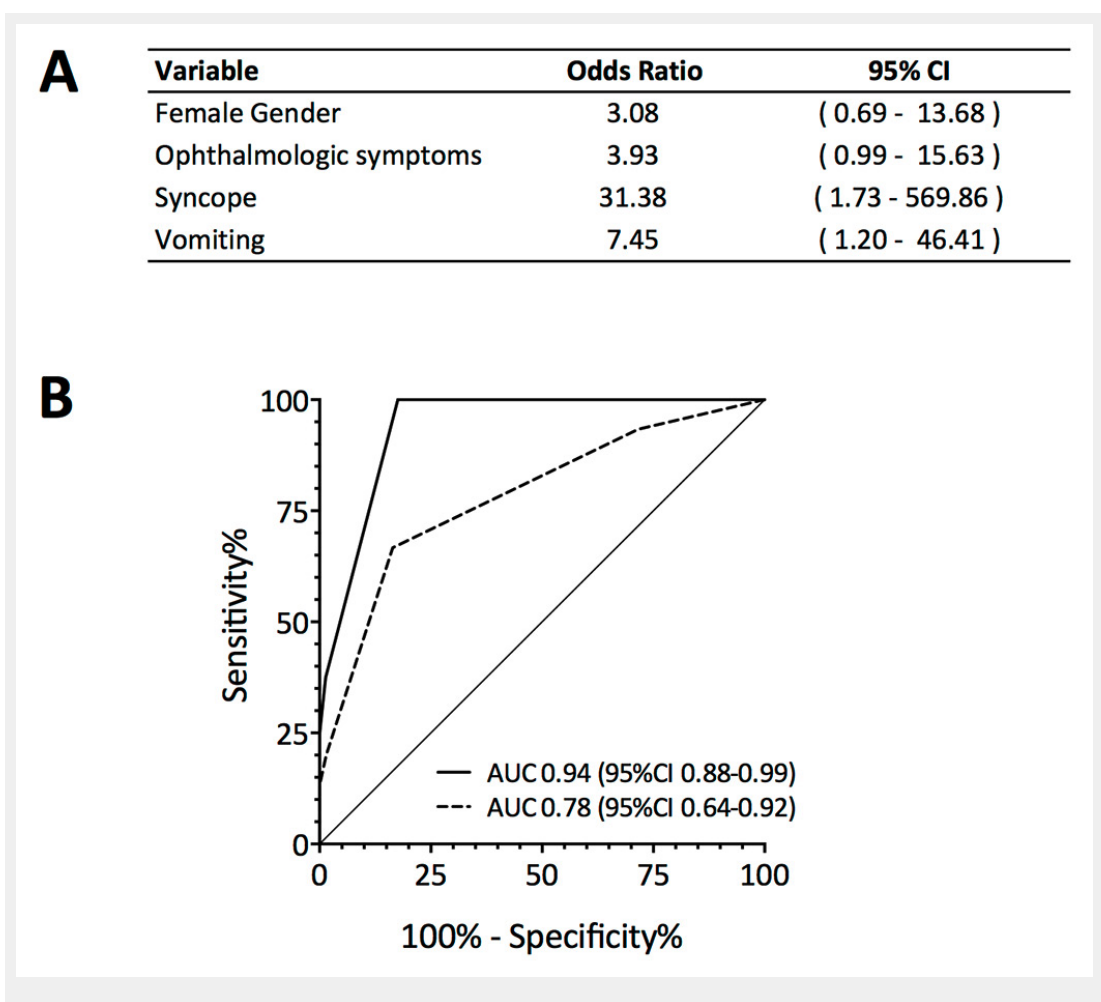
Figure 3 Statistical modelling and data visualisation using a ROC analysis of factors associated with significant magnetic resonance imaging (MRI) findings in headache patients. (A) Factors identified in binary, stepwise logistic regression analysis to be associated with significant MRI findings. (B) ROC analysis of a clinical score based on syncope (2 points), vomiting (1 point), ophthalmological symptoms (1 point), and female gender (1 point). Visualisation of a score cut-off of 2 points is displayed. Line indicates ROC analysis for “all significant findings that potentially caused headache”. Dotted line indicates ROC analysis for ‘all significant findings’. Score point distribution in the groups is indicated in figure S2 (appendix). AUC = area under the curve; ROC = receiver operating